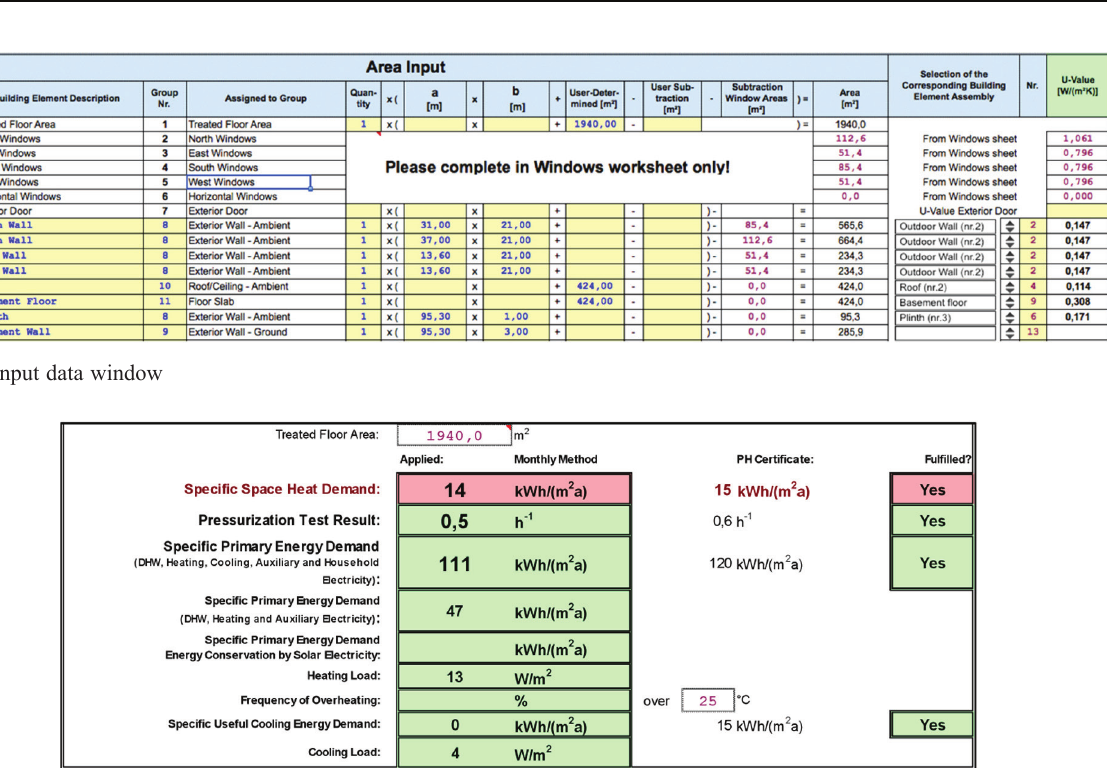
Fig. 4. Evaluation of the building energy demand using the PhPP